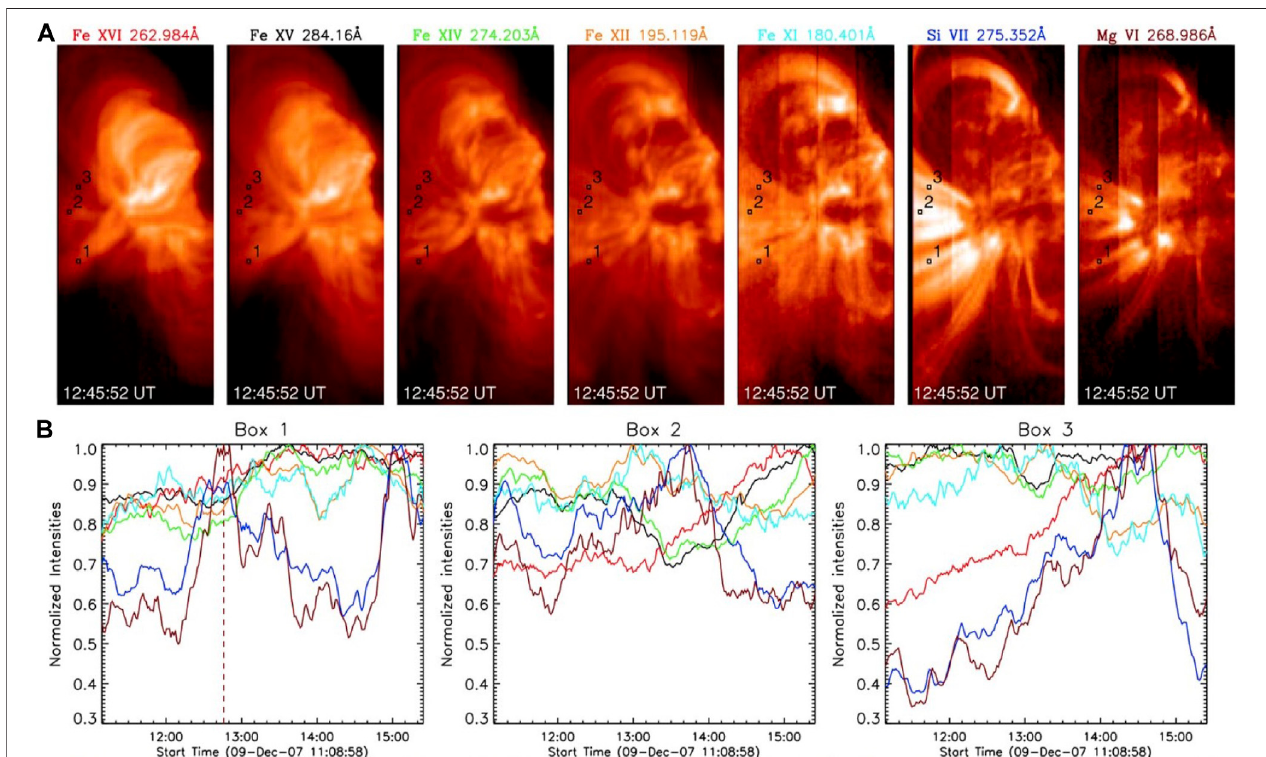
FIGURE 5 | (A) An active region observed with Hinode /EIS in multiple spectral lines, reported by Ugarte-Urra et al. (2009), ordered from left to right in decreasing orderoftemperatureformation(startingat2.62 MKwithFeXVI262.98 Å andendingat0.4 MKwithMgVI269 Å). (B) Lightcurvesinthevariousspectrallinesintegrated over Boxes 1, 2 and 3, shown in the top panels, located on peripheral cool loops. See Ugarte-Urra et al. (2009) for more details (adapted from Figure 5 in that paper, © AAS. Reproduced with